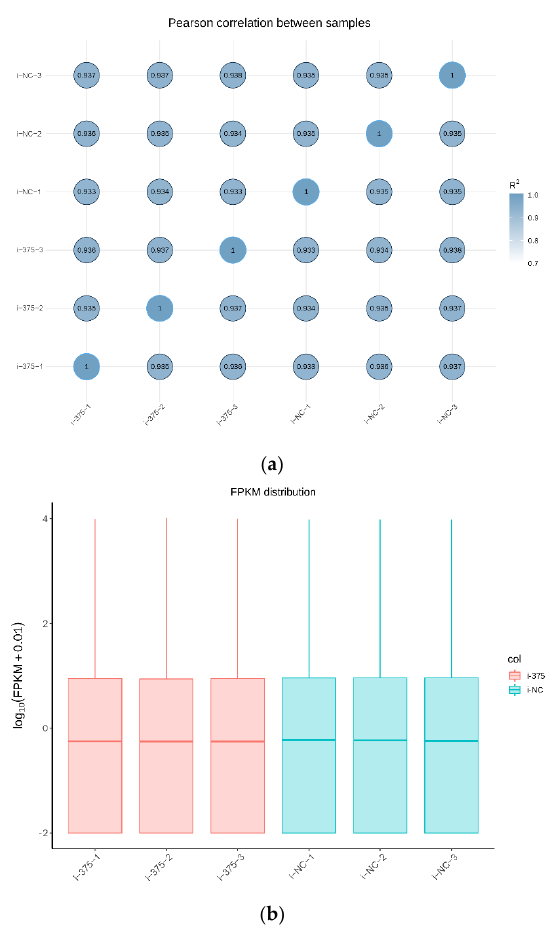
Figure 2. The correlation between samples and overall expression of mRNA in MAC-T. ( a ) Pearson ’s correlation analysis between samples. ( b ) Box-plot diagram of the FPKM of each sample.